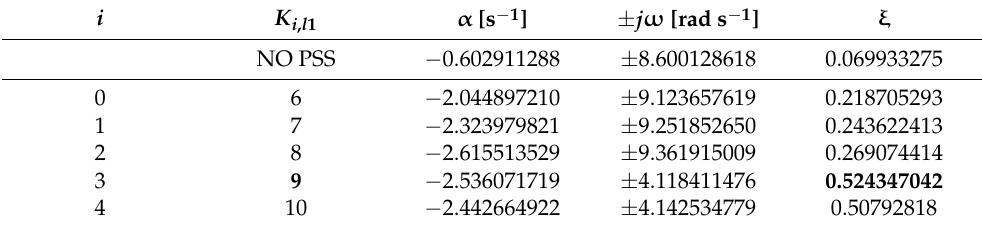
Table 5. Dominant oscillatory pole for PSS parameters T = T 1 = T 3 = 0.5 s, K i,ln = 6 – 10, n = 1 ( lower cluster 1 ).